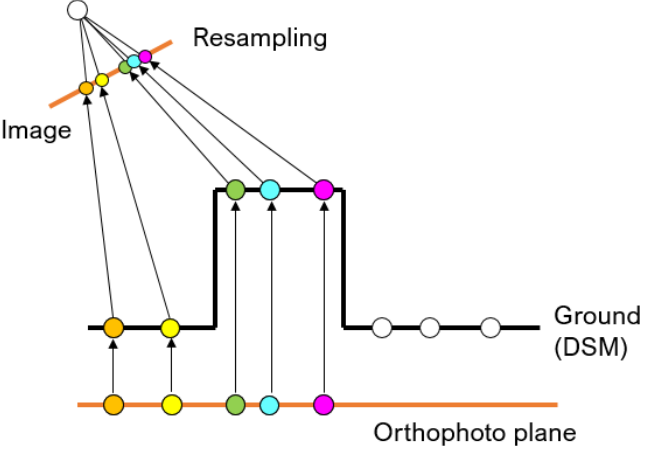
Figure 7. Schematic illustration of the indirect approach for orthophoto generation.